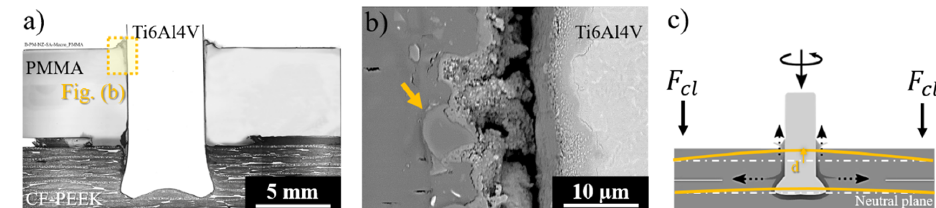
Figure 11. ( a ) Cross-section of friction-riveted with upper PMMA and lower CF-PEEK parts. ( b ) Detail of the metal-PMMA interface showing broken fibers embedded in PMMA in the rivet surroundings.